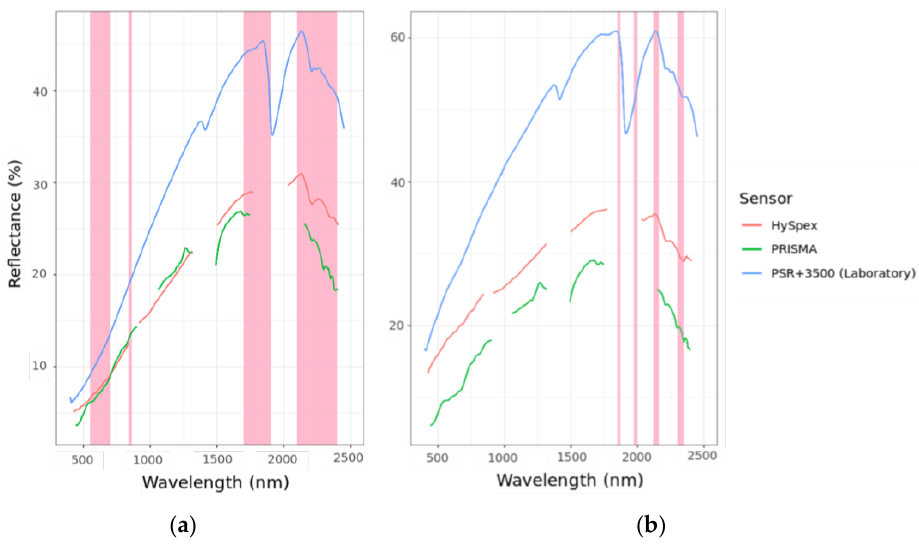
Figure 3. Spectral signatures and important wavelengths in the PSR+ 3500, HySpex, and PRISMA data for high ( a ) OM and ( b ) CaCO 3 values. The important spectral regions are highlighted in